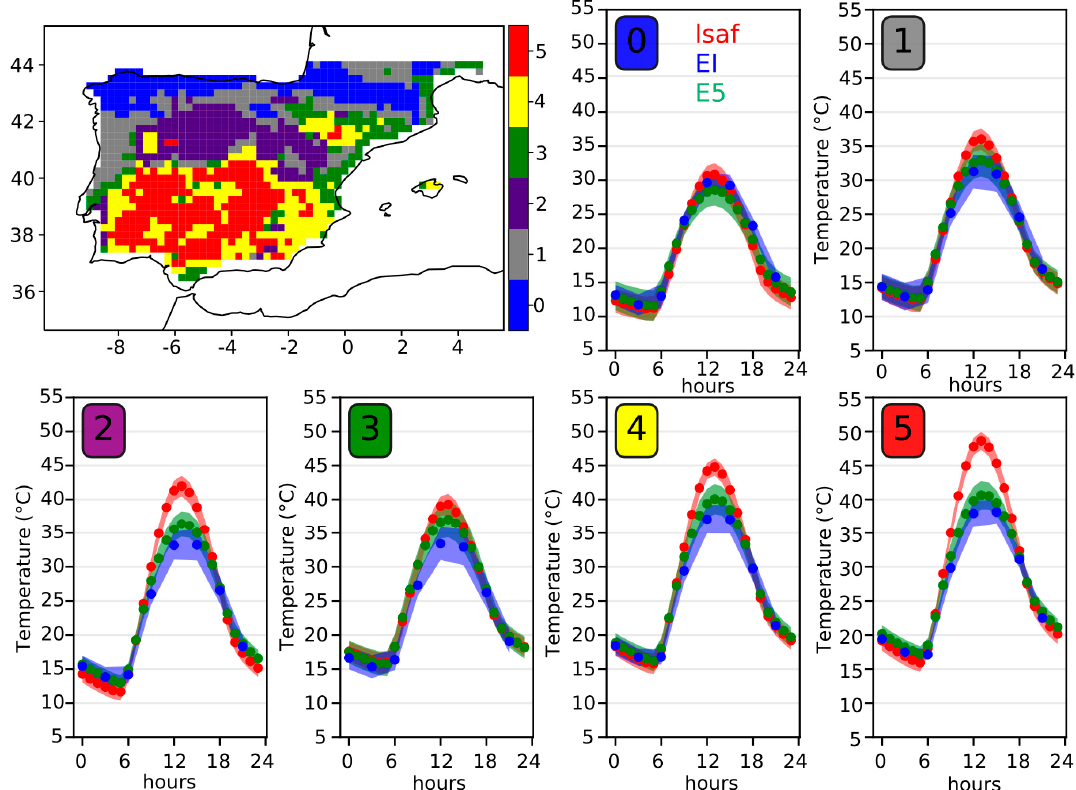
Figure 2. Clusters determined by the K-Means Algorithm with Land Surface Temperature (LST) as input ( top left ) and the 2004–2015 mean diurnal cycle (average in dots and Standard Deviation shaded) in each cluster for the satellite-LST (red), ERA5 (green) and ERA-Interim (blue). The number on the top left of each panel identifies the cluster number shown on the top left panel: ( 0 ) blue, ( 1 ) grey, ( 2 ) purple ( 3 ) green, ( 4 ) yellow, ( 5 ) red.